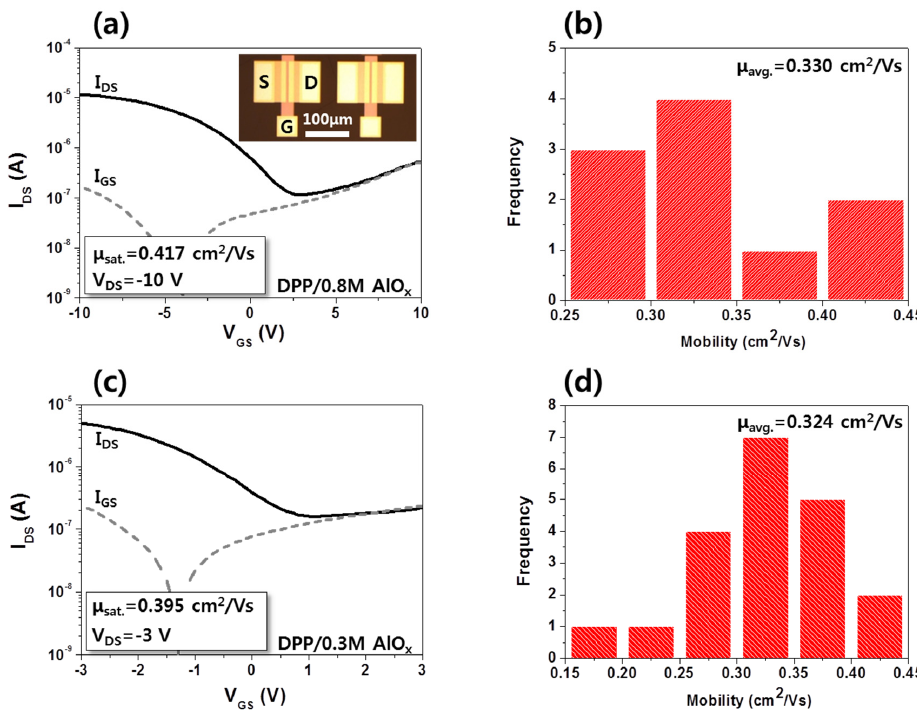
Figure 5. ( a , c ) Transfer curves and ( b , d ) statistical distributions for saturation mobility of high ‐ performance P ‐ 29 ‐ DPPDTSE polymer semiconductor devices on flexible PI film/glass substrates with 0.3 ‐ and 0.8 ‐ M AlO x sol ‐ gel concentrations,